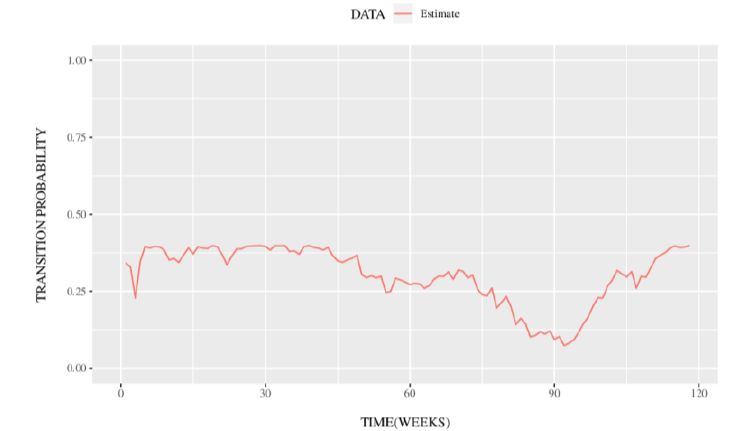
Figure 5. Fault fixing time transition probability distribution using exponential model in Eq. (22) with